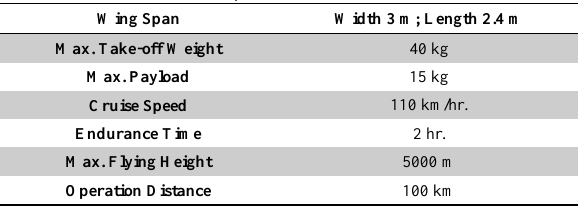
Table 2 . Specification of AL-40